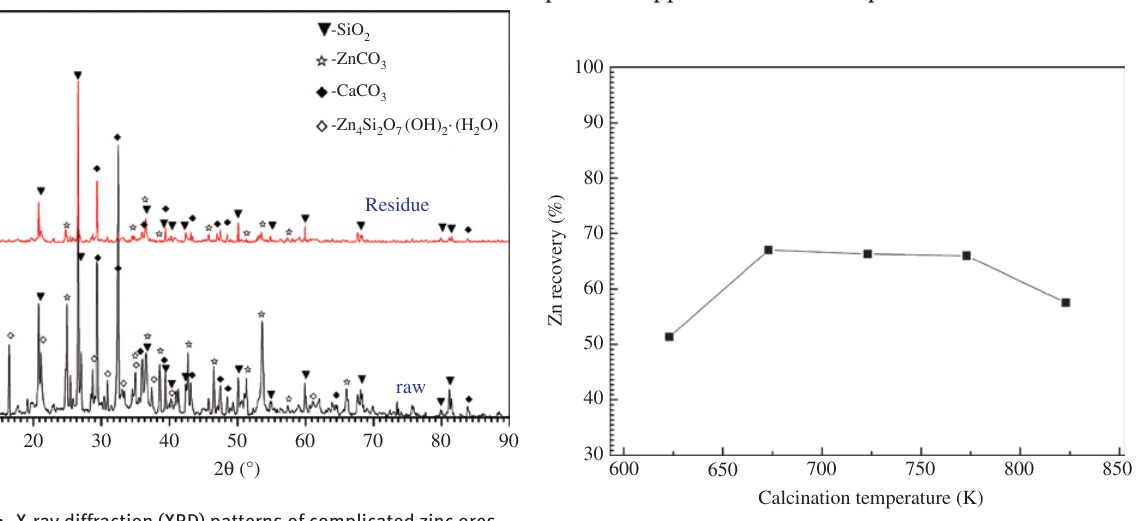
Figure 3: X-ray diffraction (XRD) patterns of complicated zinc ores before and after being leached in the solution with a total ammonia concentration of 8 mol/l.